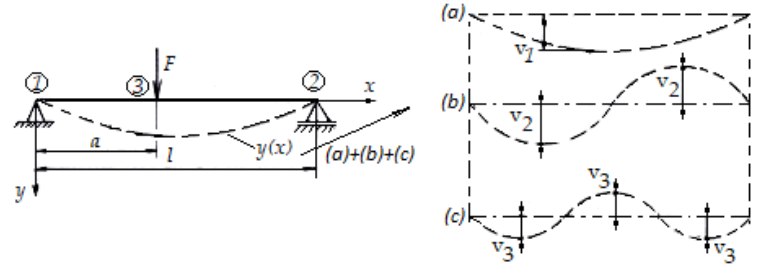
Figure 3. Representation of the deformed average fi ber as a sum of “n” sinusoids.